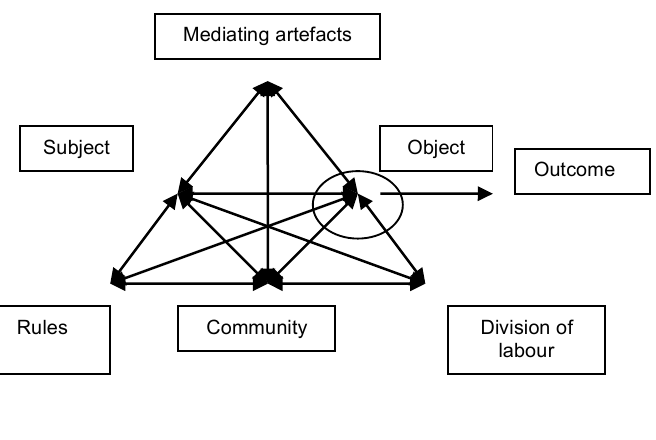
Figure 1: Conceptualisation of the structure of human activity (Adopted from Engeström,